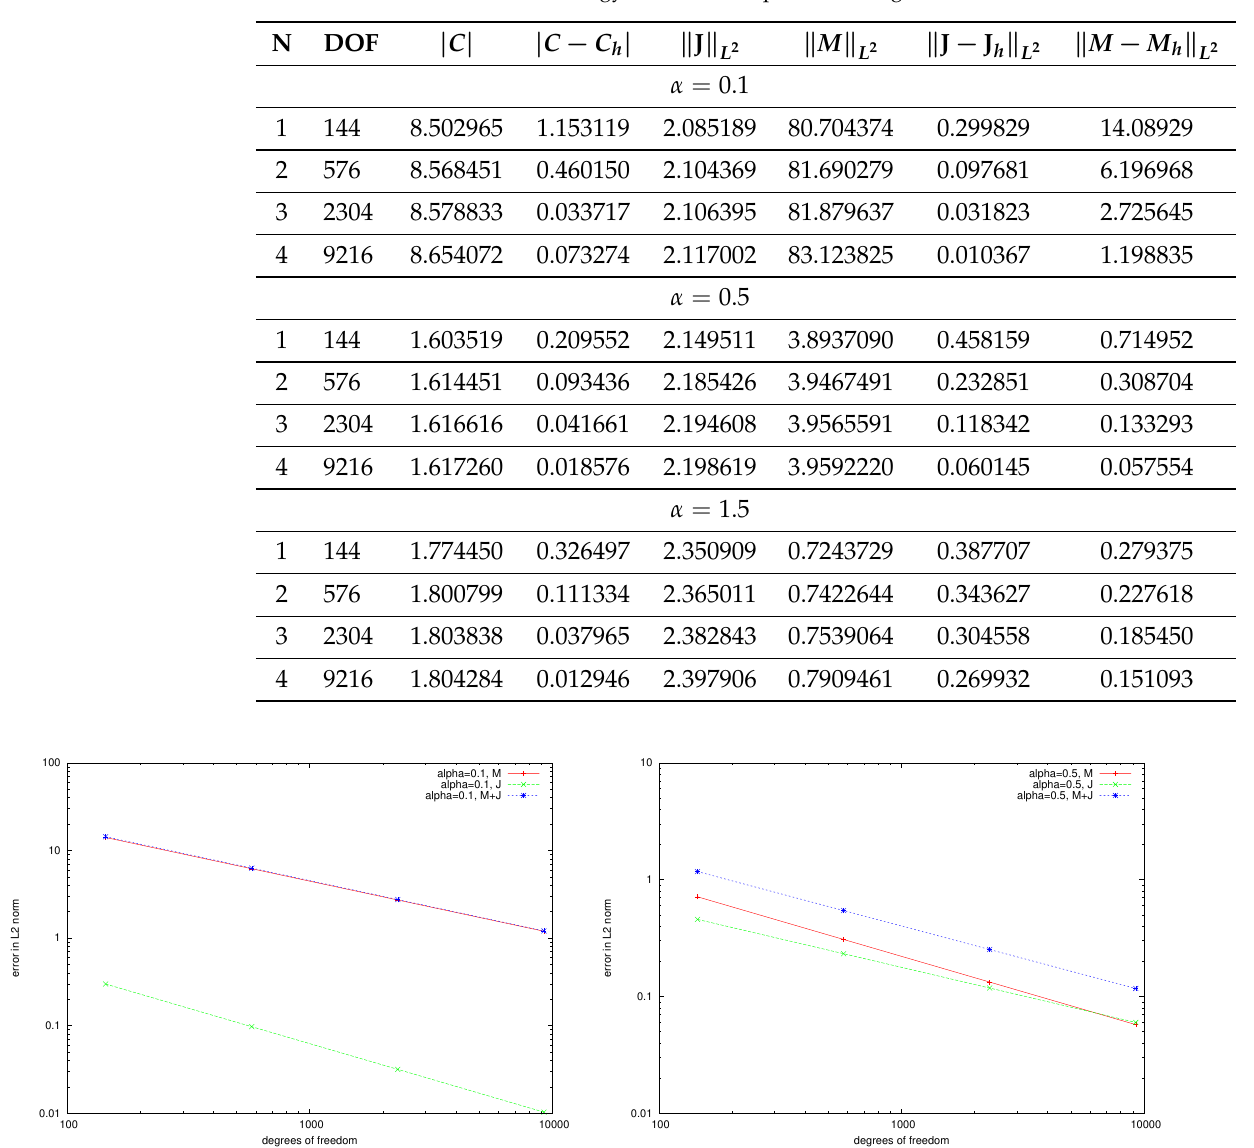
Table 1. Errors in L 2 -norm and energy norm with respect to the degrees of freedom for α = 0.1,0.5,1.5.